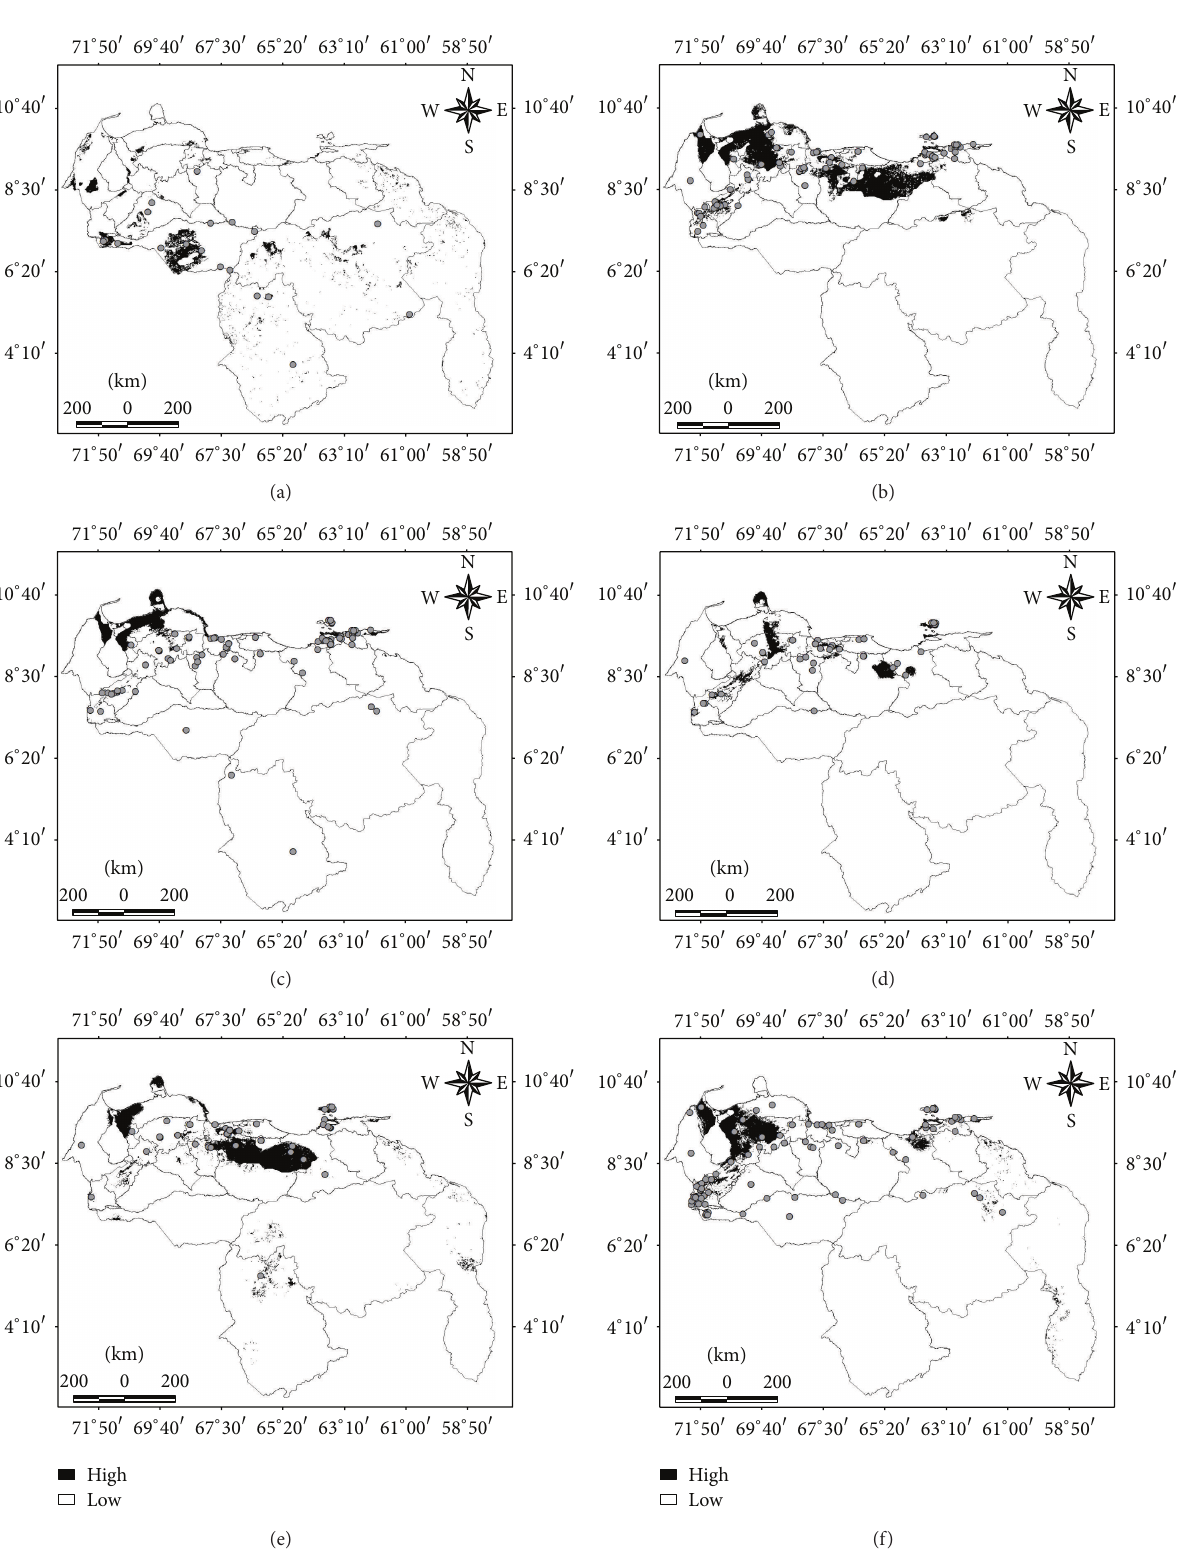
Figure 1: Distribution of sandflies species in Venezuela and gray points denoted occurrences and black areas high probability of relative habitat suitability. Maps are provided for (a) Lutzomyia antunesi , (b) L. atroclavata , (c) L. c. cayennensis , (d) L. dubitans, and (e) L. evansi and (f) L. gomezi